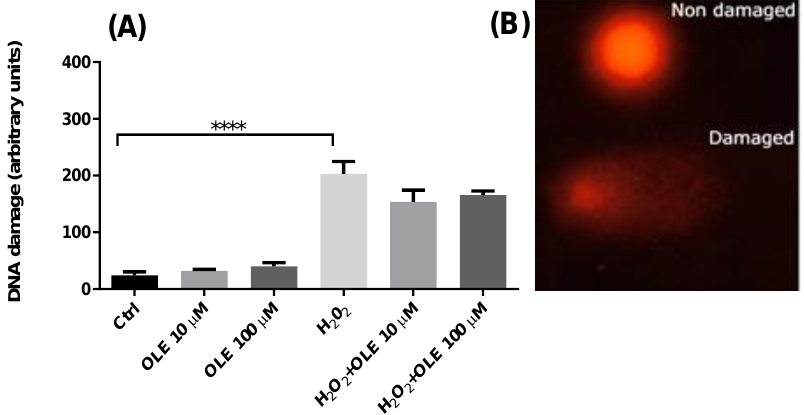
Figure 3. ( A ) Genotoxic potential of oleuropein (OLE) and antigenotoxic effects against H 2 O 2 -induced damage in HTR-8/SVneo cells. The data are expressed as mean + SEM. **** p < 0.0001. ( B ) Appearance of comets without DNA damage (Non damaged) and with DNA damage (Damaged).